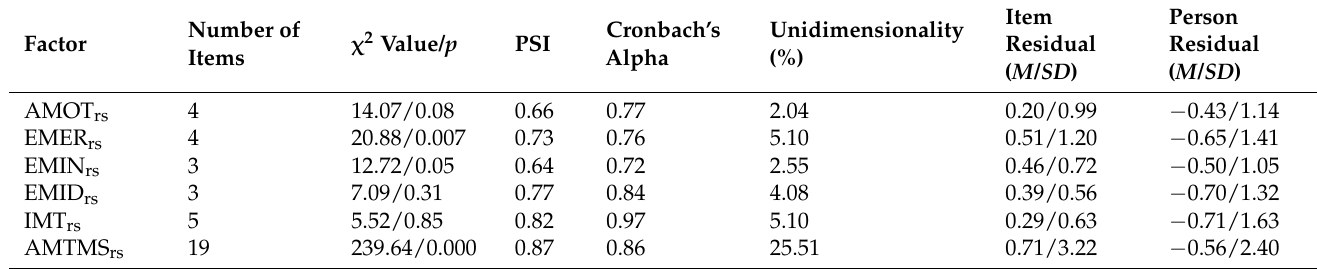
Table 5. Fit, undimensionality and reliability indices of AMTMS re-scored.